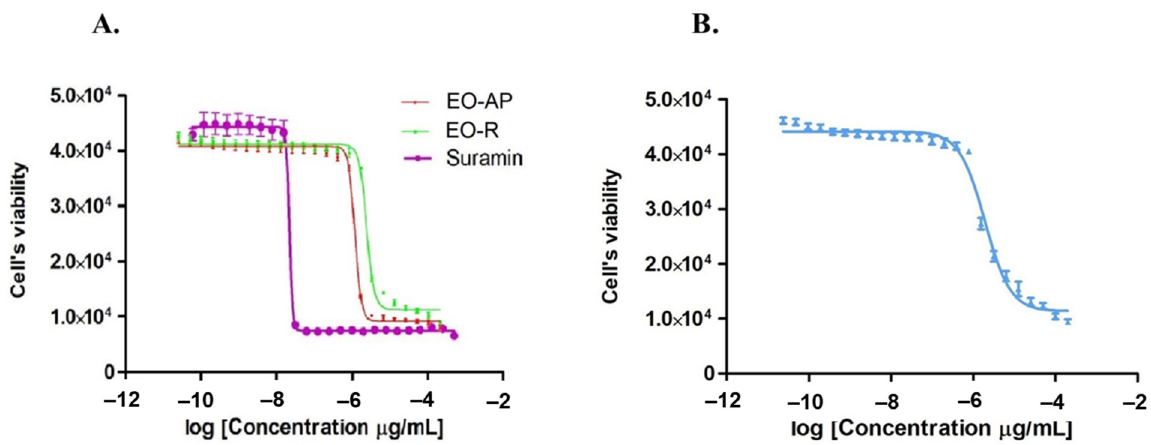
Figure 1. Growth inhibition of T. brucei s427 cells by A. nemorosa EO from aerial parts (EO-AP) and roots (EO-R) and by farnesene. ( A ). Growth inhibition of T. brucei treated with EO-AP (red curve) and EO-R (green curve) with Suramin as control (purple curve). ( B ). T. brucei growth inhibition with farnesene.